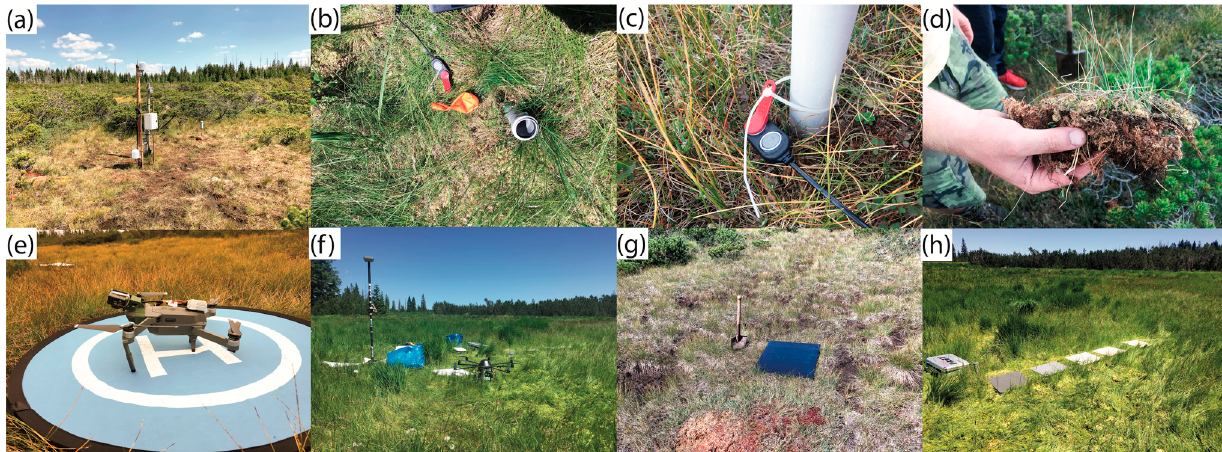
Figure 3. ( a ) Hydrograph, ( b ) groundwater level (GWL) tube, ( c ) Tbutton installed at GWL tube, ( d ) surface soil sample for gravimetric soil water content (GWC) estimation, ( e ) DJI Mavic with RGB and thermal camera, ( f ) Octo XL with white target and GNSS, ( g ) black GCP target for thermal imagery, and ( h ) calibration targets for the multispectral camera.